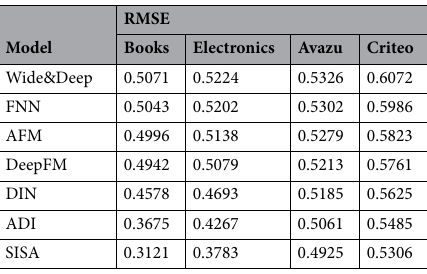
Table 3. Overall CTR prediction for RMSE performance in different